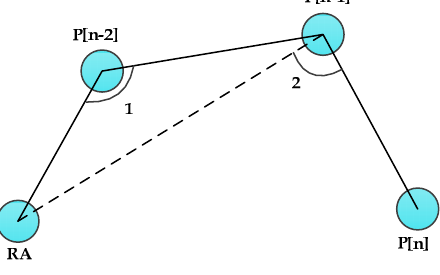
Figure 6. Trajectory with a longer detour.